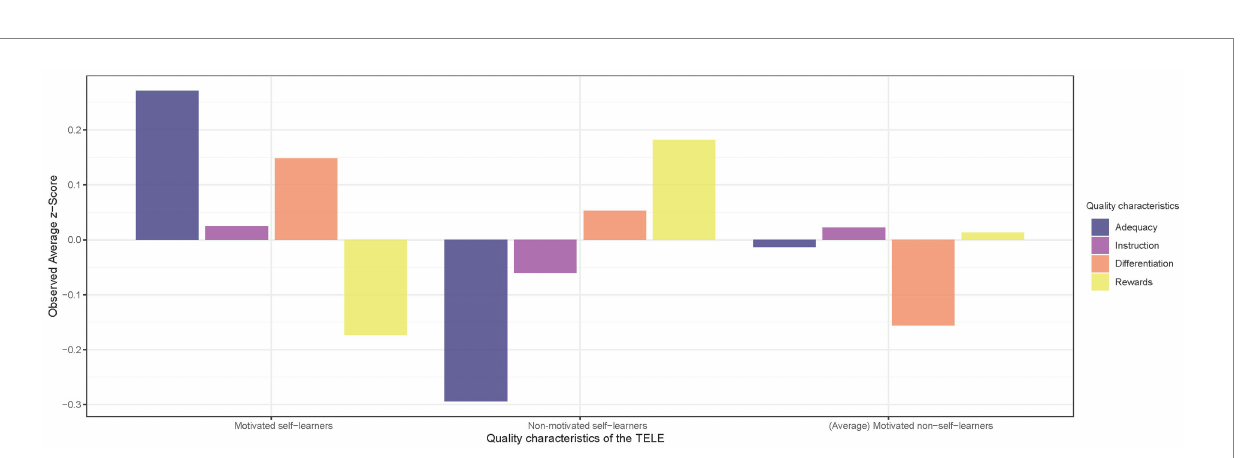
FIGURE 3 Observed average z -score for the rating of the quality characteristics differentiated between the three self-regulated learning (SRL) profiles.